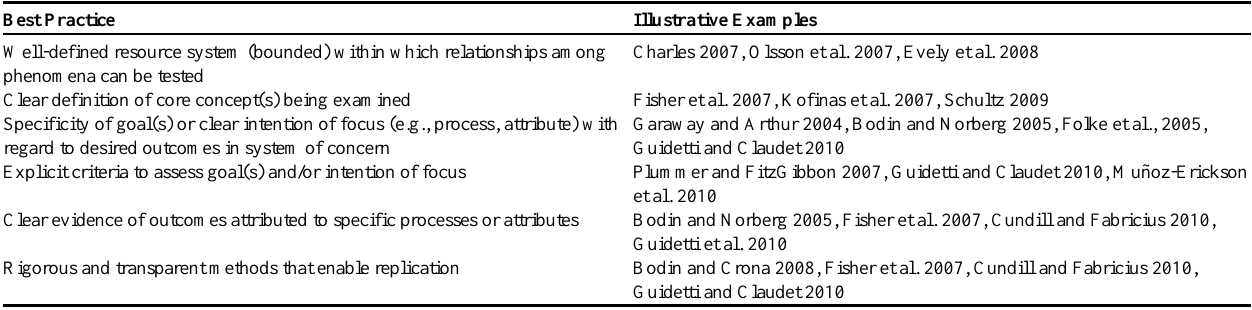
Table 9. Example best practices of acm study design elements to derive comparative insights Best Practice Illustrative